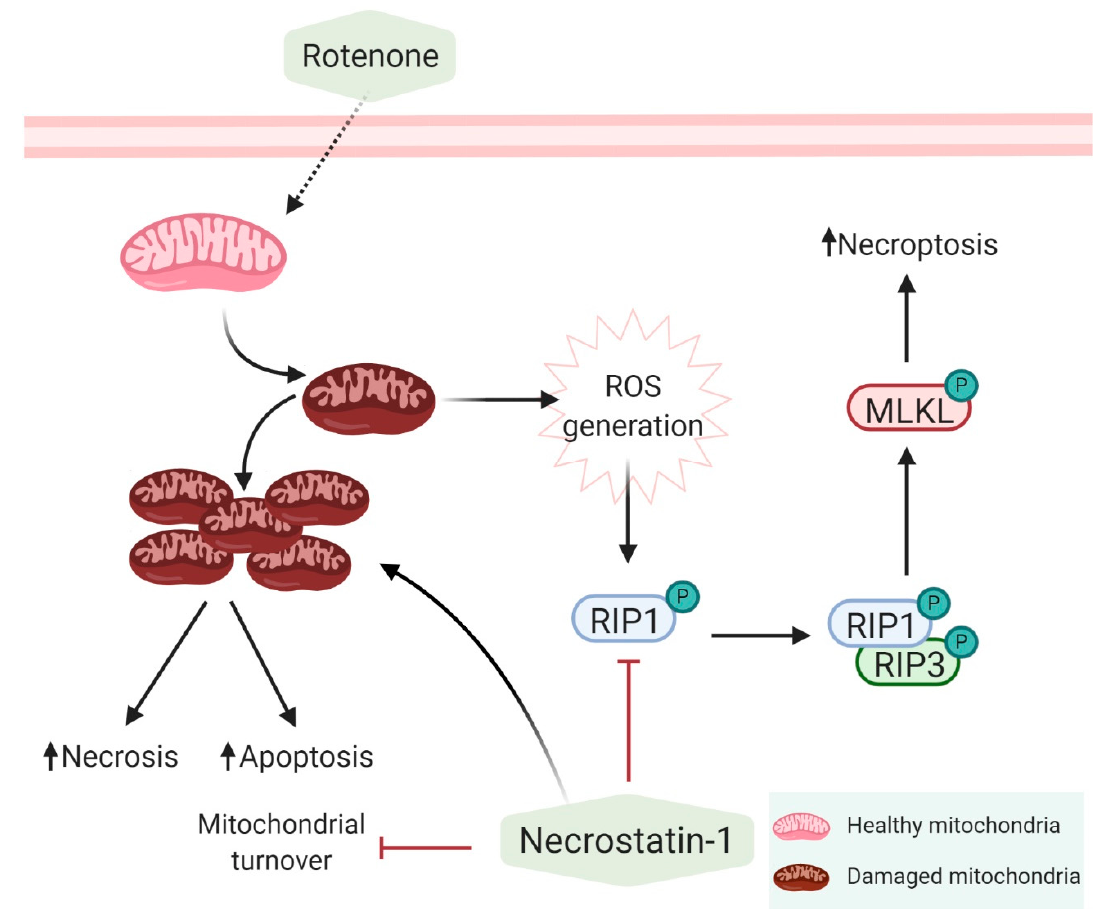
Figure 6. Mechanisms of action of rotenone and necrostatin-1. Rotenone inhibits the mitochondrial complex I and increases the production of reactive oxygen species (ROS) which, in turn, activates necroptosis via RIP1. Inhibition of RIP1 by Nec-1 inhibits necroptosis but does not reverse the effect of rotenone on complex I. In addition, Nec-1 inhibits mitophagy and exacerbates the toxicity of rotenone.